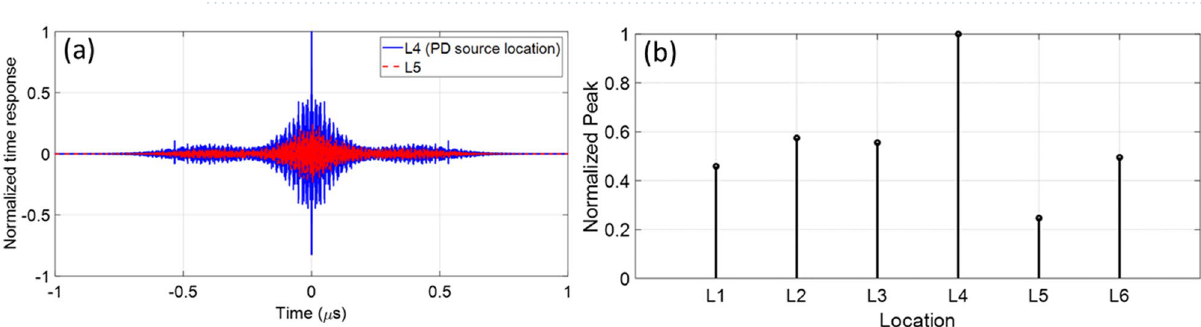
Figure 10. ( a ) Normalized time reversed responses for two guessed locations L 4 and L 5 . L 4 is the PD source location. ( b ) The normalized peak values of the time reversed response at the guessed locations L 1 to L 6 . The maximum peak occurs at L 4 , which corresponds to the PD source location. In this scenario the metallic object is